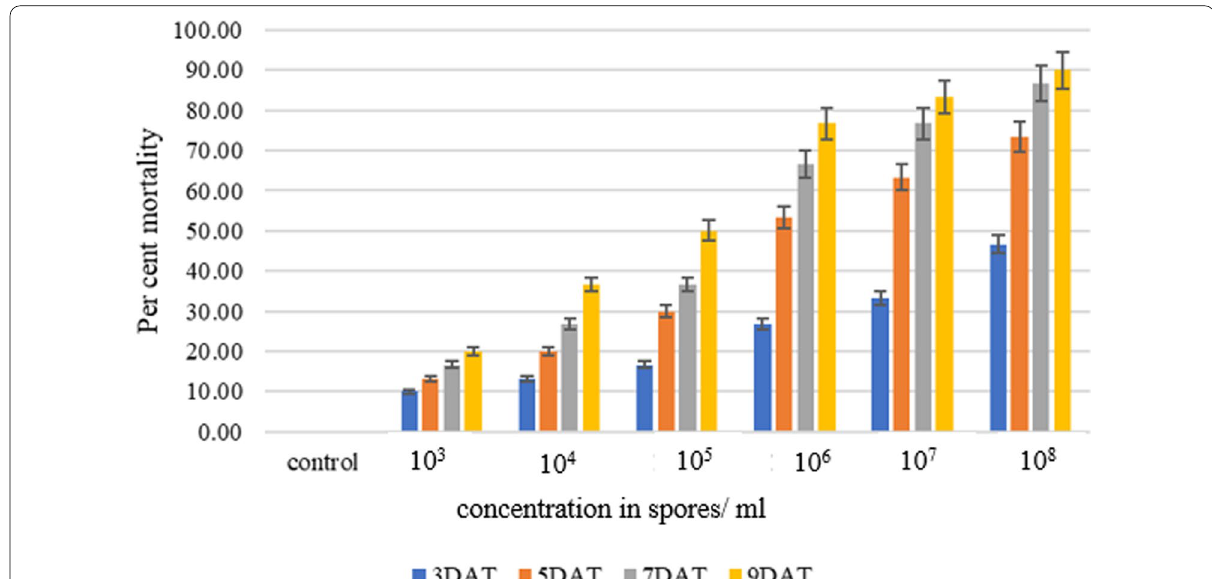
Fig. 1 Concentration mortality response of M. anisopliae treated with different spore concentrations of Metarhizium anisopliae (TNAU-MA-GDU)